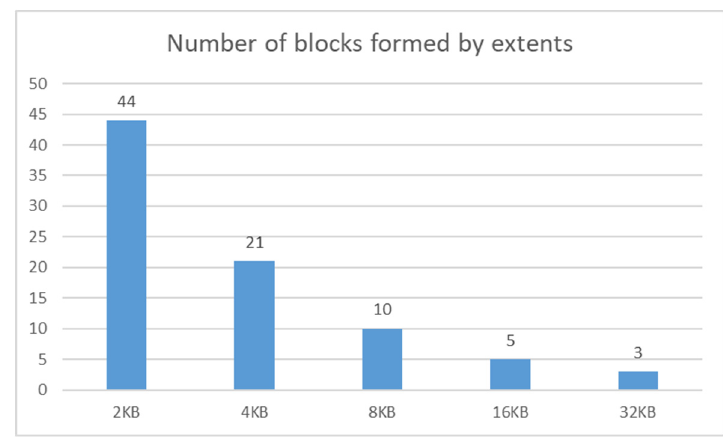
Figure 18. Results – number of blocks formed by extents. Figure 18. Results—number of blocks formed by